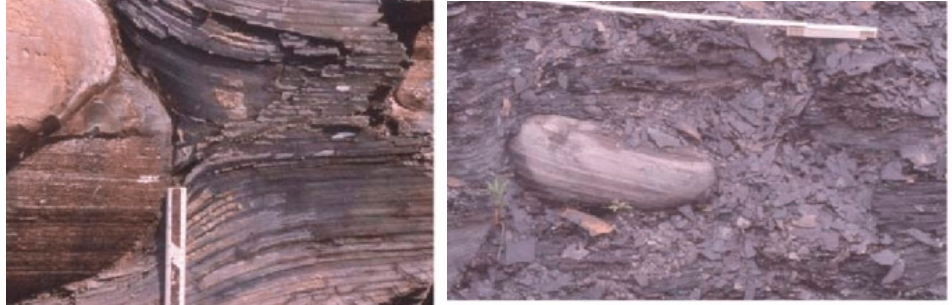
Figure 1. Carbonate concretions of the Rhinestreet shale [17].